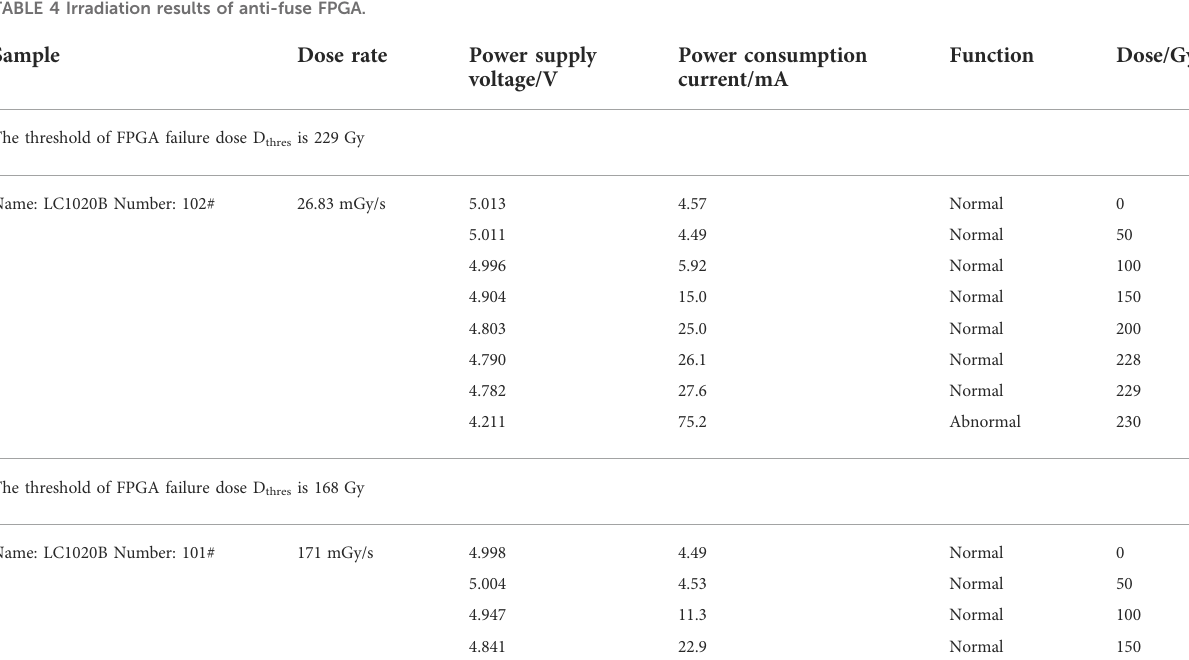
TABLE 4 Irradiation results of anti-fuse FPGA.